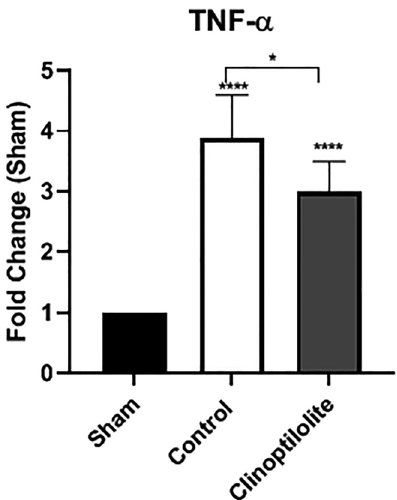
Figure 1: Comparison of TNF- α expressions of control, sham, and clinoptilolite treatment groups rat.